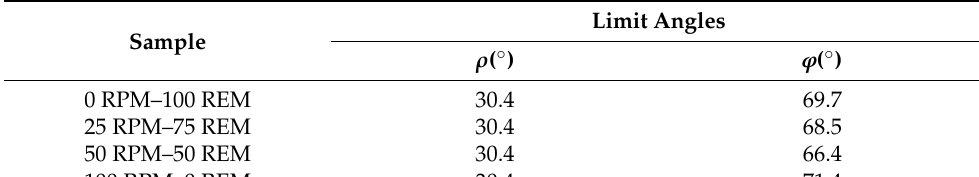
Table 4. Mobilized angle of friction ρ ( ◦ ) and incremental angle to failure ϕ ( ◦ ) for REM and RPM in pure and blended state.